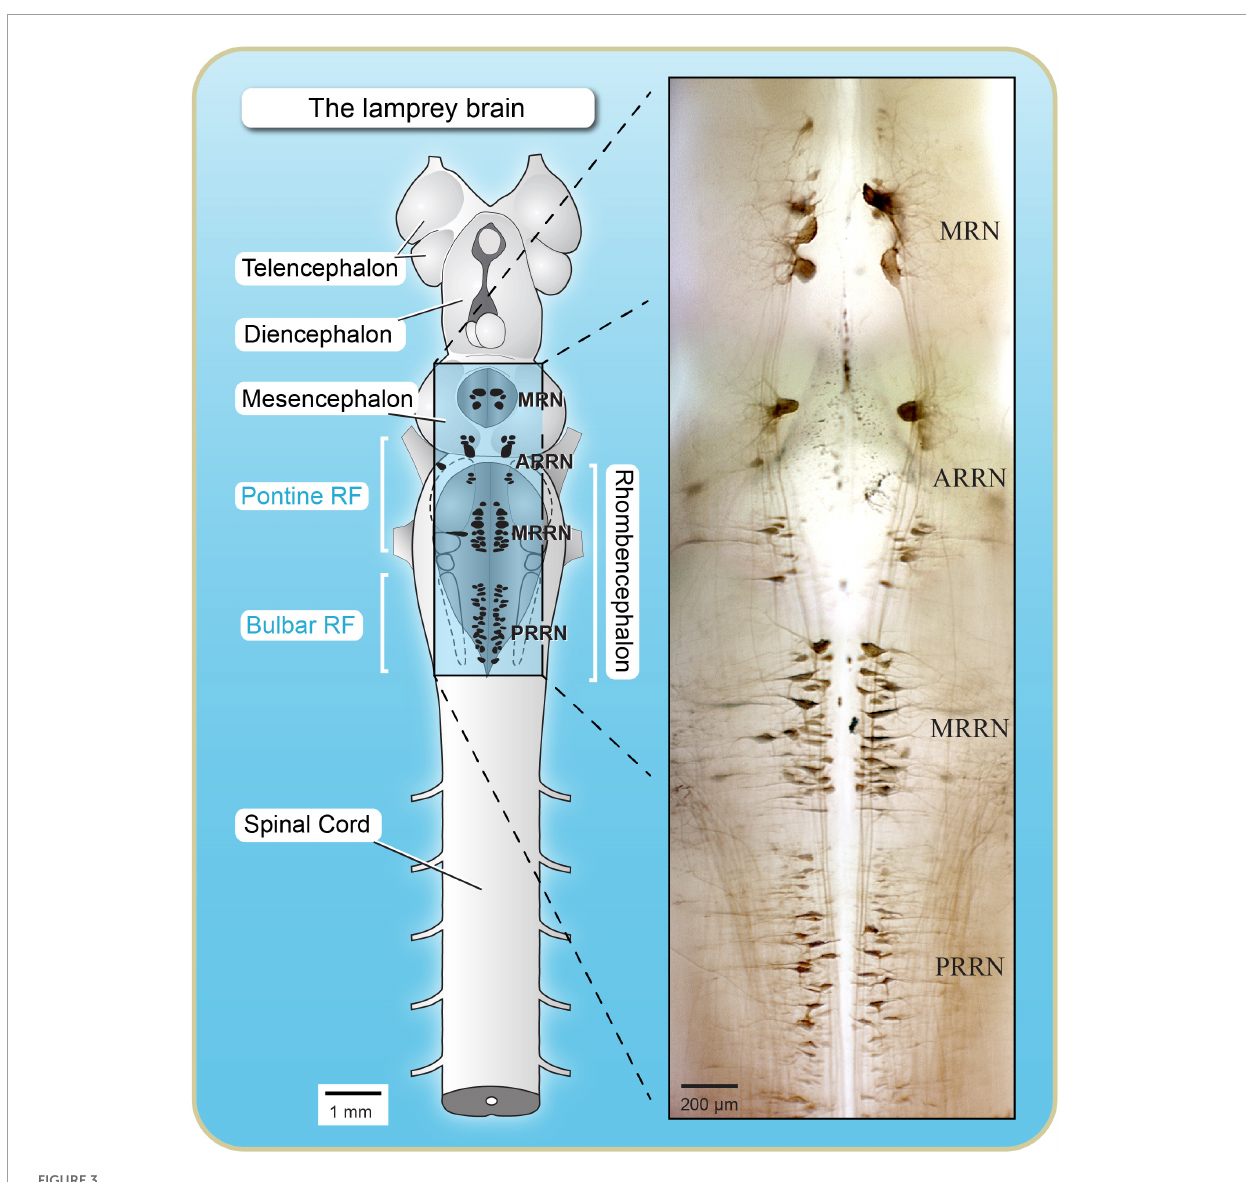
FIGURE3 Dorsal view of the brain and rostral spinal cord of lampreys illustrating reticulospinal cells that were labeled by an injection of cobalt-lysine in the rostral spinal cord. (Left) Schematics illustrating the location of reticulospinal neurons (dark cells). (Right) Brain mounted on a microscope slide (wholemount preparation). Many of the reticulospinal cells are located just below the ventral surface of the fourth ventricle (PRRN, MRRN, and ARRN), making them easily accessible for intracellular/patch recordings/imaging as well as for local injections of drugs. Adapted from Bussières